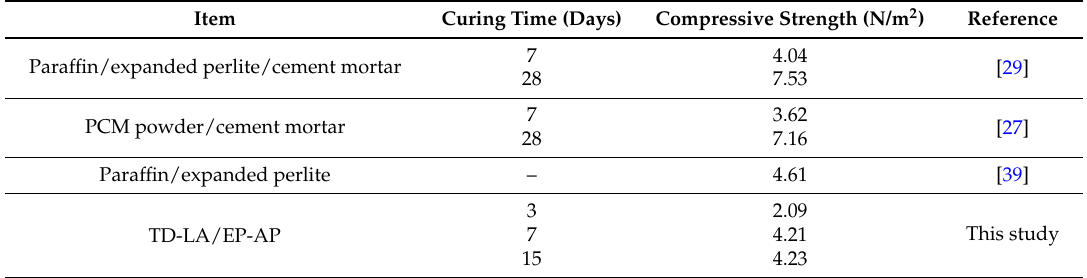
Table 5. Compressive strength results of the novel PCMP and several composites PCMs in references.